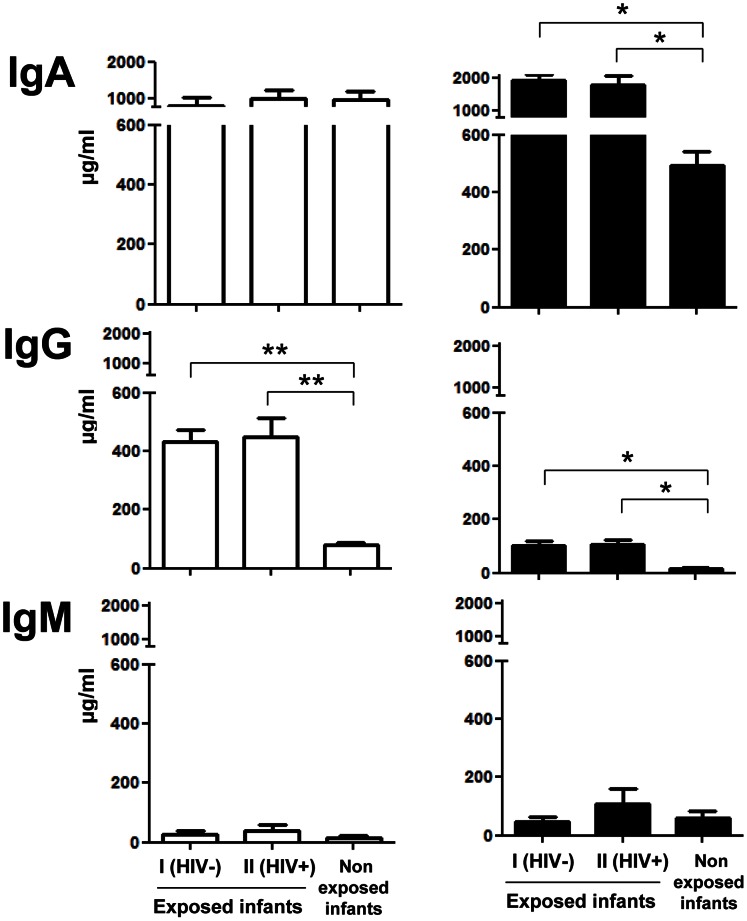
Levels of total IgA, IgG and IgM in breast milk (white bars in left) and children’s stools (black bars in right) samples from 8 HIV-1-infected mothers and their breast milk exposed non HIV-infected babies (group I), 6 couples of HIV-1-infected mothers and their breastfed HIV-infected babies (group II), and 10 healthy HIV-negative breast-feeding women and their breastfed non HIV-infected babies as negative controls.The mean concentrations of milk IgA were higher than those of IgG or IgM in HIV-infected mothers as in HIV-negative mothers. The levels of milk IgG was 5.5 higher in HIV-infected mothers than in HIV-negative mothers. The levels of stool IgA and IgG in babies born from HIV-infected mothers were higher than those of HIV-negative control babies. Immunoglobulins levels are expressed in µg/ml ± standard error. The stars indicate the significant differences by comparison to HIV-negative control samples (* P<0.01).